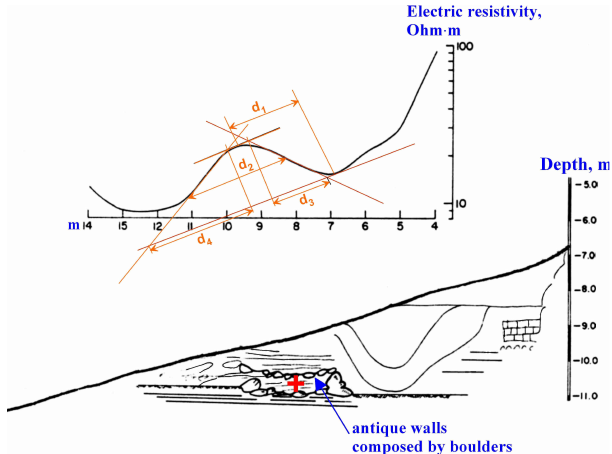
Fig. 14. Inverse problem solution for resistivity anomaly in the archaeological site of Tel Afek, Central Israel (initial data from Ginzburg and Levanon, 1978). A cross in the section designates the location of the center of anomalous